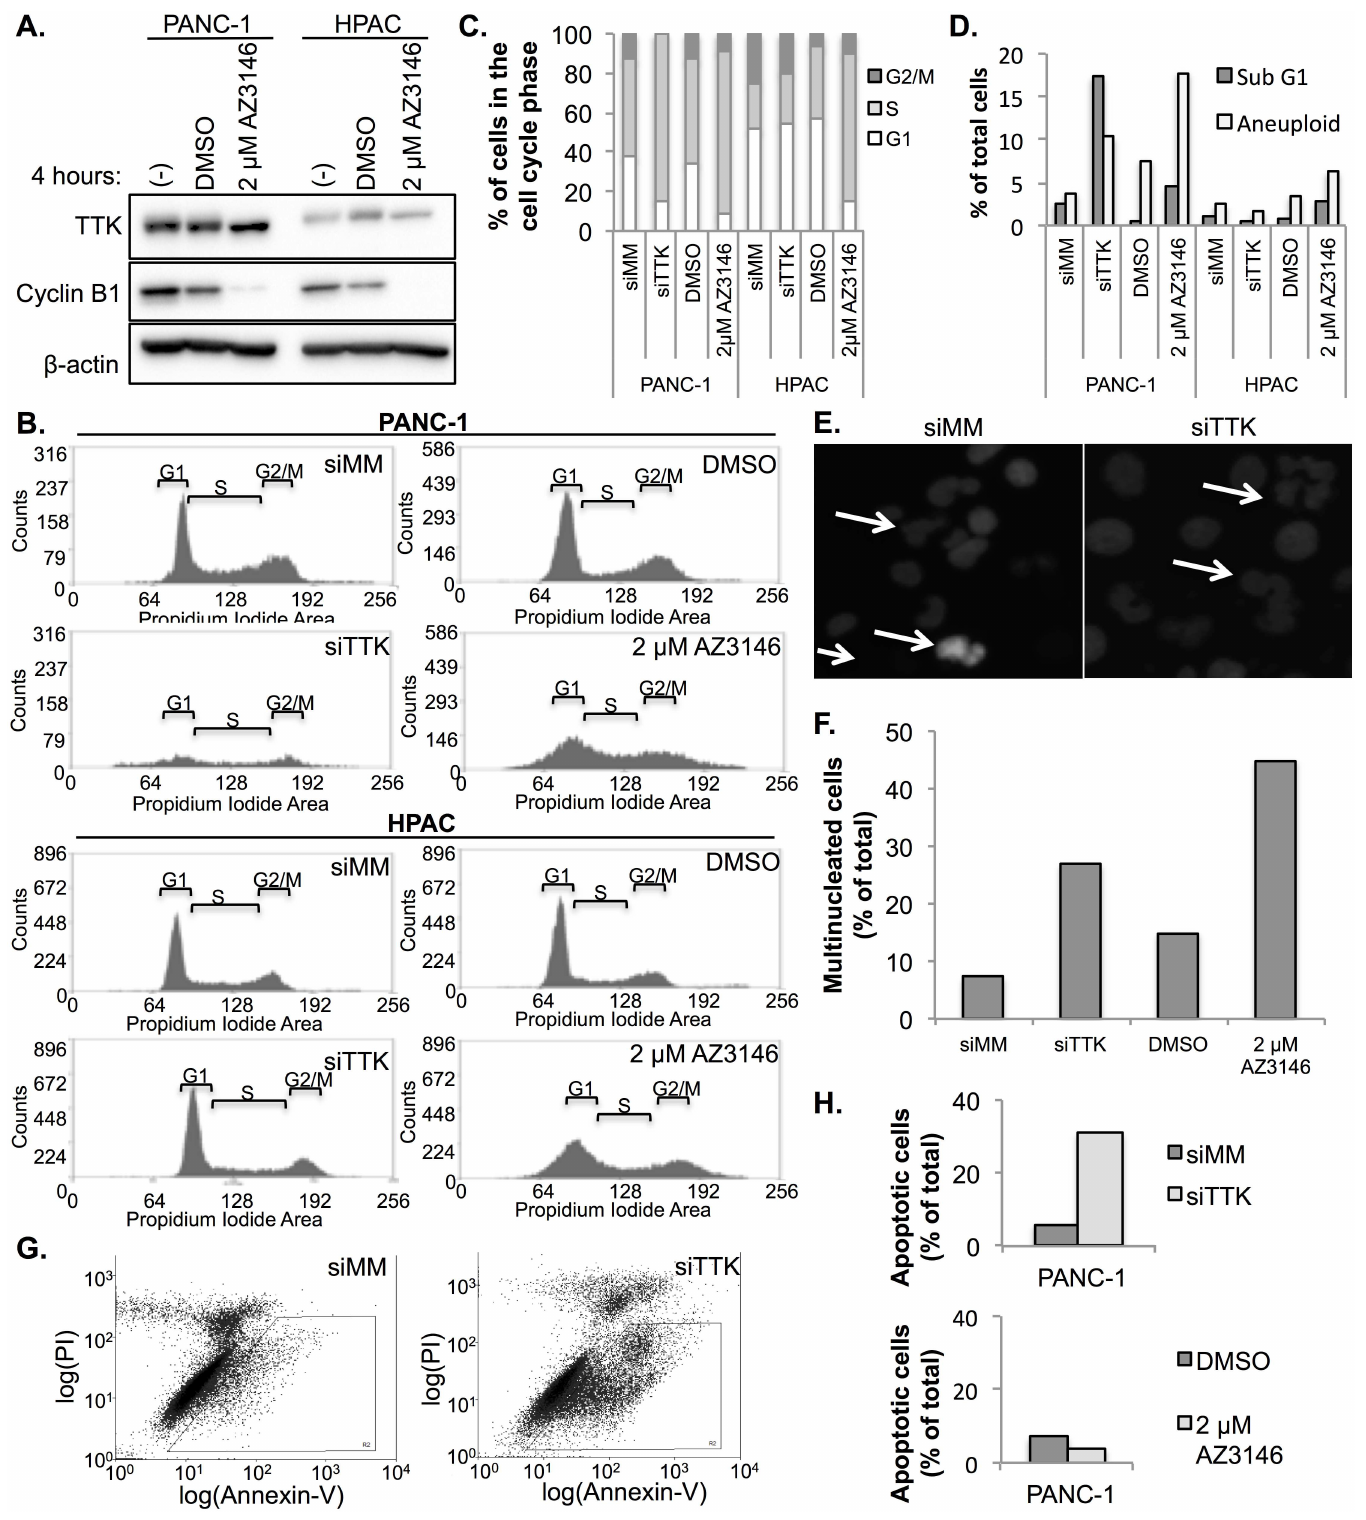
Fig 4. TTK inhibition overridesthe SAC mediated cell cycle arrestand leads to aberrant cell cycle progression, multi-nucleation and apoptosis. (A) Immunoblotof HPAC and PANC-1 PDAC cell lines arrested in mitosis by treatment with nocodazole. Cells were then treated with 2 μ M AZ3146for 4 h and probedfor expressionof cyclin B1. (B) Representative flow cytometry plots of the cell cycle of HPAC and PANC-1 cell lines of 2 experiments. Cells were